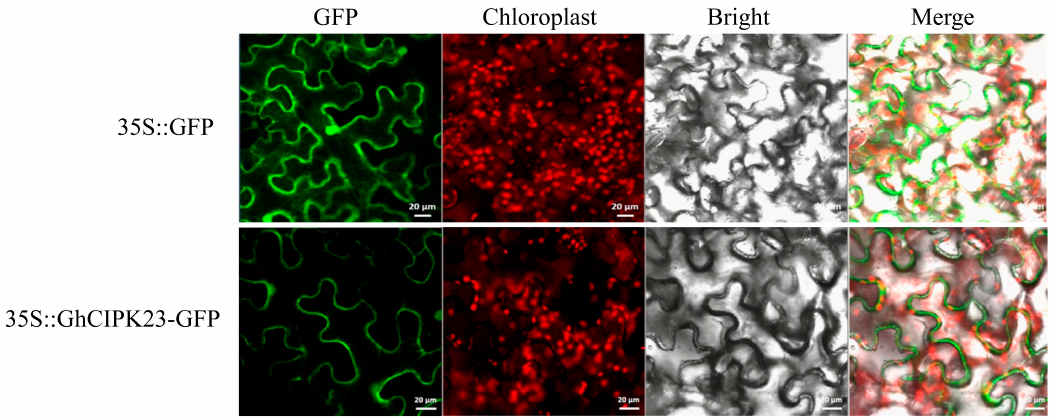
Figure 5. Subcellular localization of GhCIPK23 protein in upland